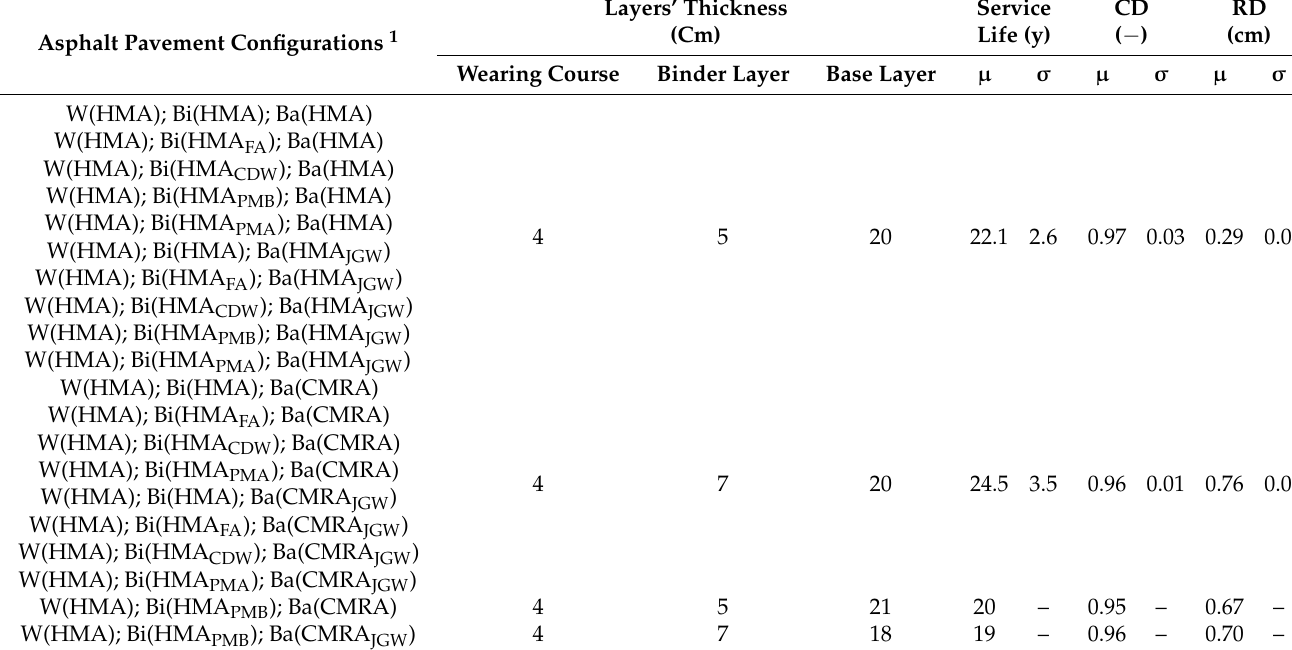
Table 6. Asphalt pavement configurations, thicknesses of the asphalt layers, mean ( µ ) and standard deviation ( σ ) of the service life, cumulative fatigue damage, and rut